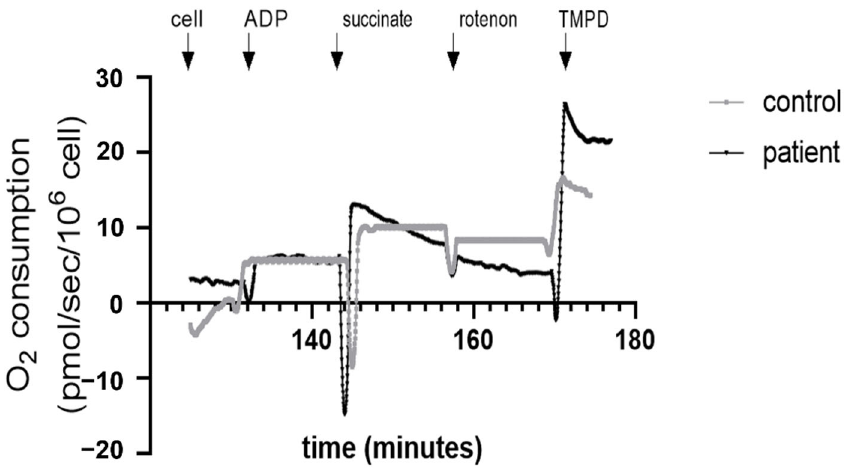
Figure 1. Representative image of mitochondrial respiration of Peripheral Blood Mononuclear Cells (PBMCs) in control and heart transplanted patients.